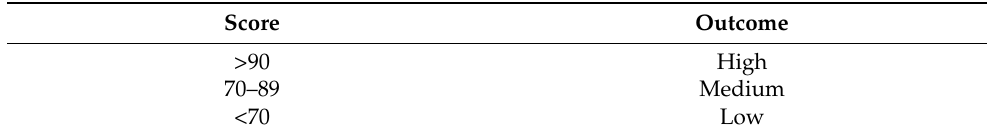
Table 3. A scoring range and outcome for the Government Stringency Index, the Health and Containment Index, and the Economic Support